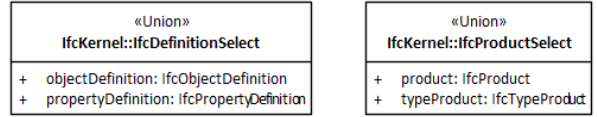
Figure 7. UML class diagram showing examples of IFC select datatypes converted to UML unions.